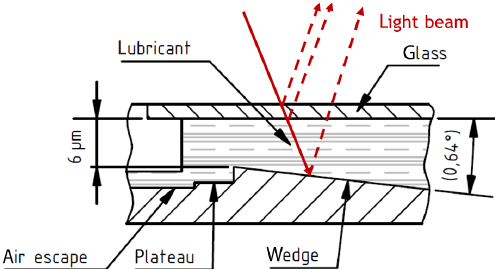
Figure 2. Principle cross-sectional diagram of the thin-film thick- ness standard with a sketched light beam.